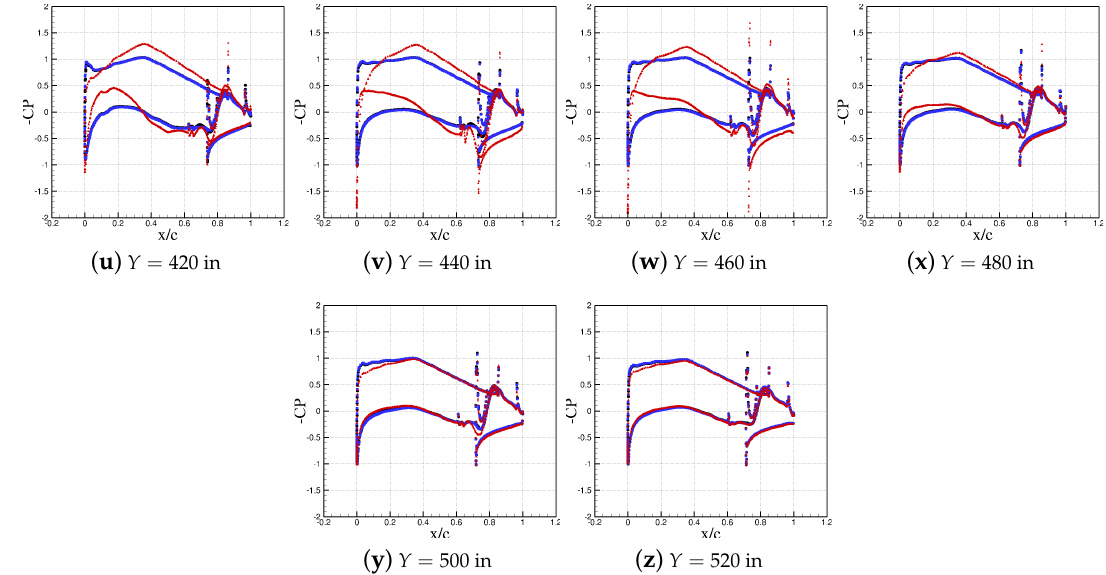
Figure 7. Pressure distribution ( − C p ) over the wing for wing only and a wing with a prop mounted either on the inboard or outboard nacelle; the propeller spins counterclockwise and has a 20-deg blade angle. Black dots show no prop. Blue-colored square markers show a propeller mounted on the wing inboard. Red triangles show a propeller mounted wing outboard. Pressure data are time-averaged for the final three seconds of